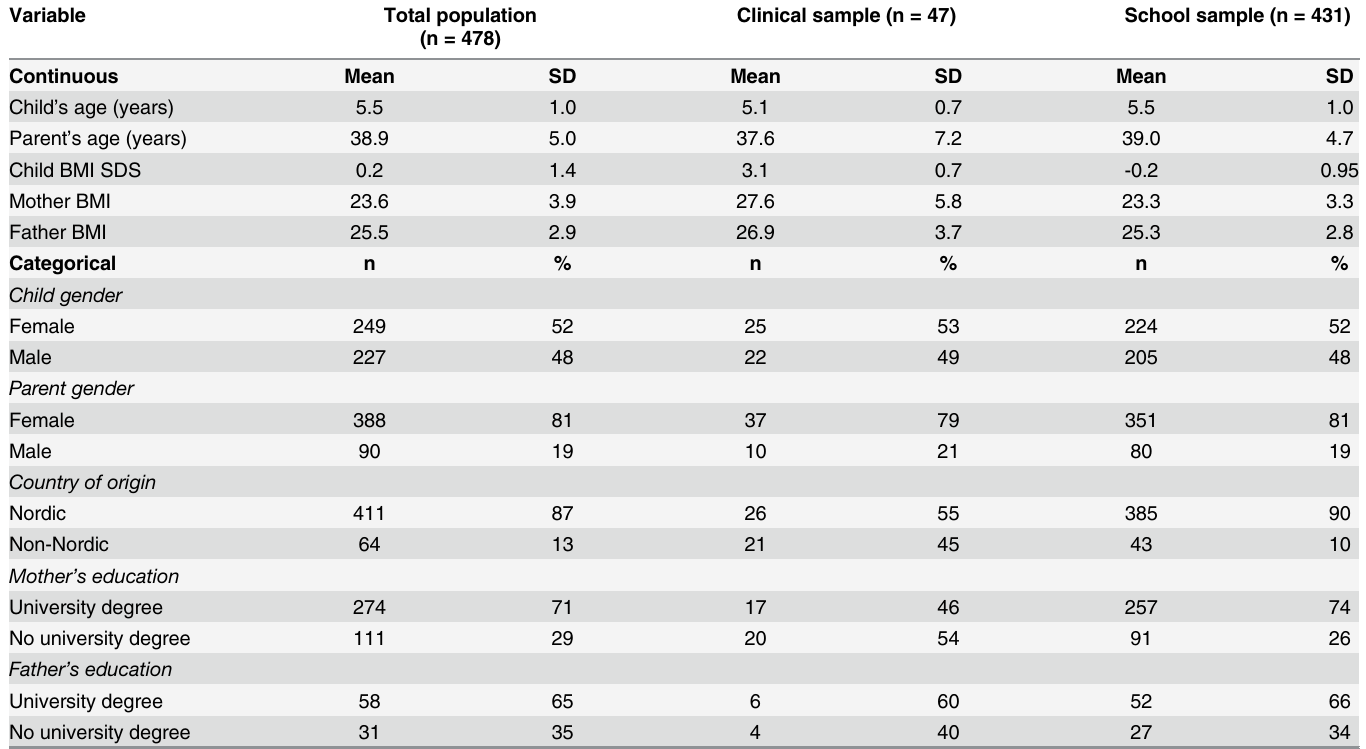
Table 1. Characteristics of the